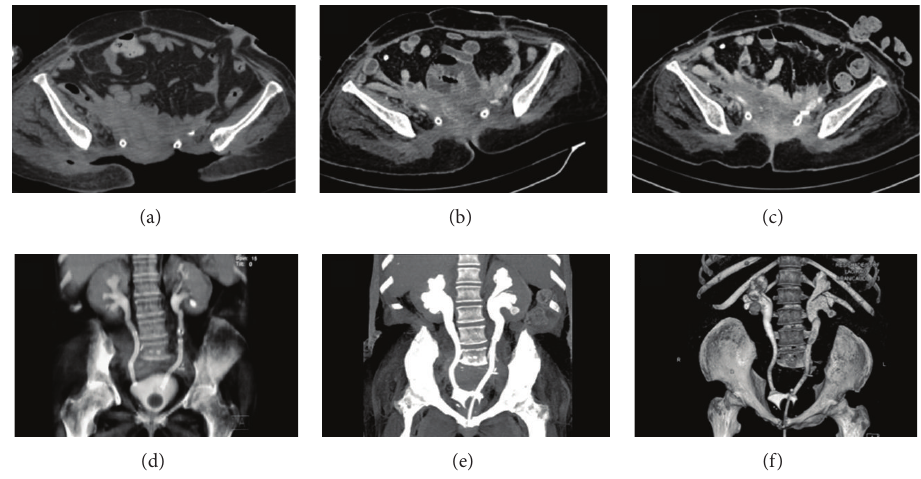
Figure 4: Contrast-enhanced CT scan (a) the day after the ureteral stents were positioned. Contrast-enhanced CT scan performed in January 2012 (b) and in April 2012 (c): the surgical wound shows a progressive healing and there is no ureteral leakage. Maximum intensity projection (MIP) CT-reconstruction showing the correct position of the two ureteral stents after 8 (d) and 18 months from the procedure (e). 3D CT- volume rendering after 18 months from the procedure